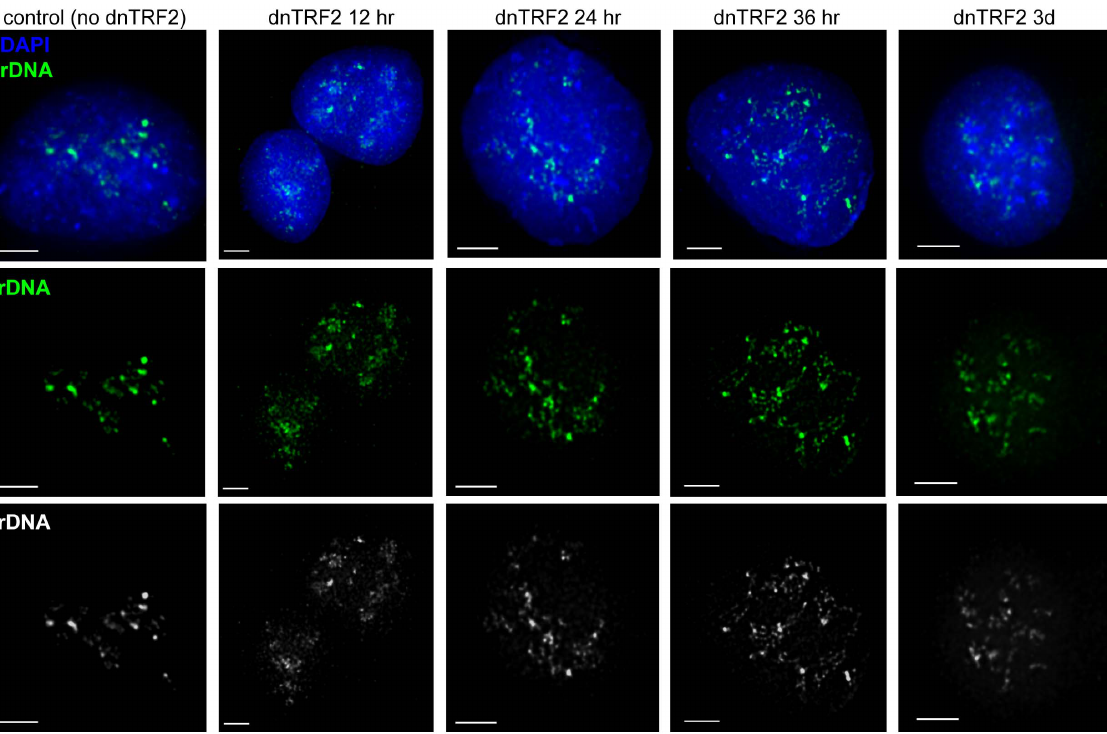
Figure 3. dnTRF2 expression correlates with rDNA repeat array dispersion. The rDNA arrays are located on the short arms of the 5 pairs of acrocentric chromosomes. FISH on RNase-treated nuclei hybridized with an rDNA (green) PAC probe showed that rDNA, normally appearing as multiple punctate foci in the nucleus, becomes more diffuse with increased dnTRF2 expression. The T19 (dnTRF2) cell line contains , 18 acrocentric chromosomes. Multiple short arms normally converge in the nucleus, so each foci can contain more than rDNA regions from more than one acrocentric chromosome. With increased dnTRF2 expression and telomere dysfunction, the bright foci were reduced, instead appearing as dotted or beaded tracks of fluorescent signals stretching throughout the nucleus. Pseudo-colored and gray-scale single channel images for rDNA are shown below the merged images. Scale bars equal 5 micrometers.